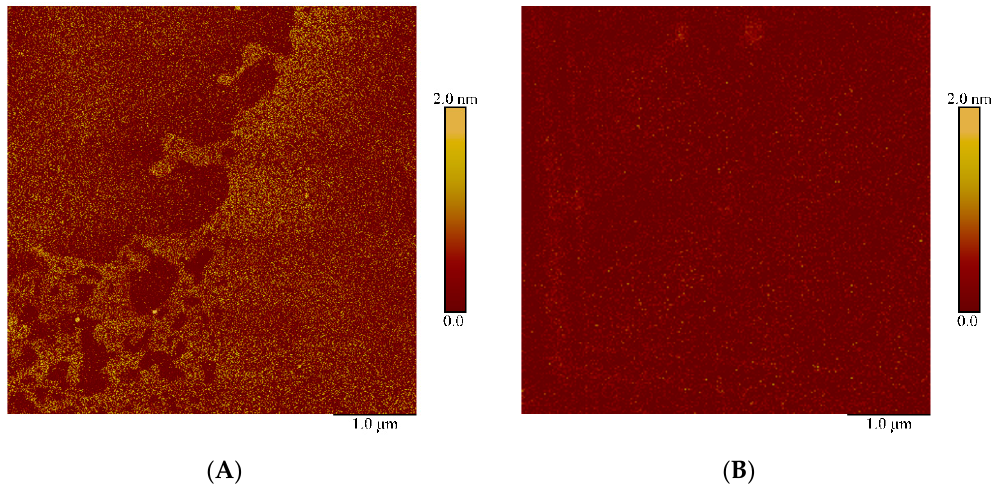
Figure 6. Typical AFM images obtained after incubation of SuccBB-activated ( A ) and non-activated ( B ) APTES-modified mica in 10 − 9 M HSA solution upon UV irradiation.